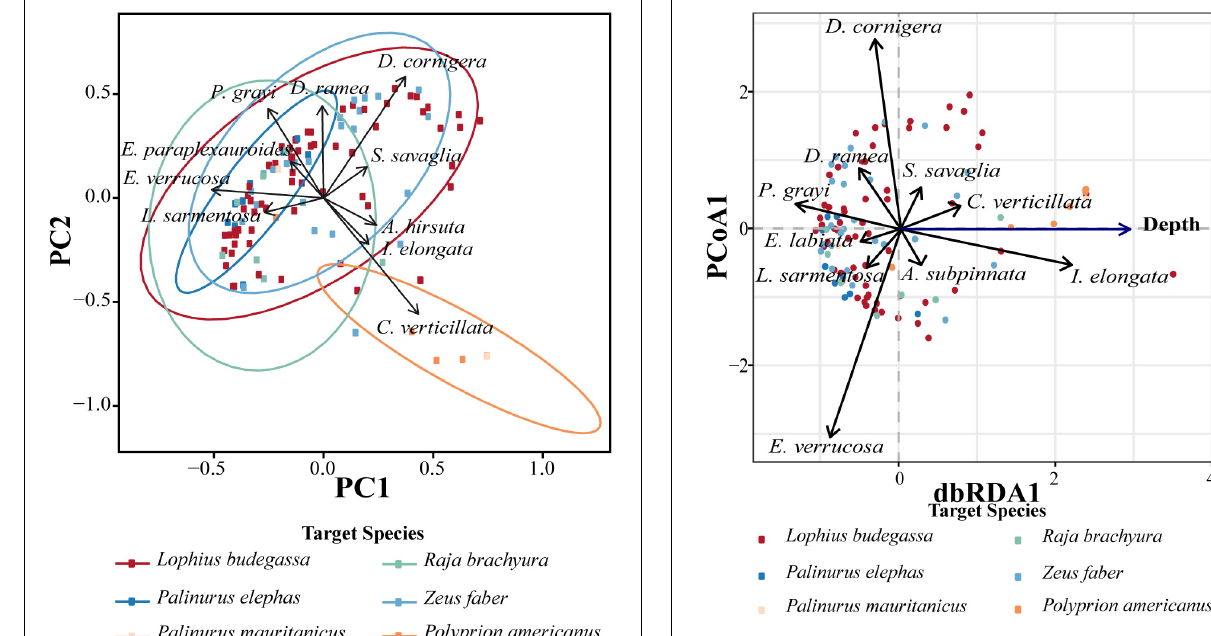
FIGURE 7 | Principal coordinate analysis (PCoA) showing the variation in the coral species community structure from bycatch using bottom-set gillnets during two sampling seasons off the coast of Sagres (Portugal). PCoA plot based on species composition per net deployed and métier. The species matrix describing the ecological resemblance per net was calculated using the Hellinger distance. The vectors display the Pearson correlations ( p -value < 0.05) between the descriptors (i.e., coral species captures per net) and the PCoA1 and PCoA2. PCoA biplot of the métier documented in both sampling seasons. Significant groupings defined by métier are shown in color. For more information concerning the PCoA, refer to Section “Materials and Methods.”